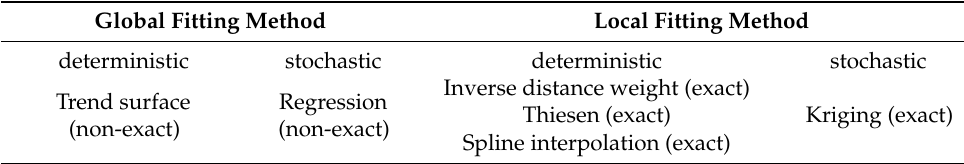
Table 2. Classification of spatial data interpolation